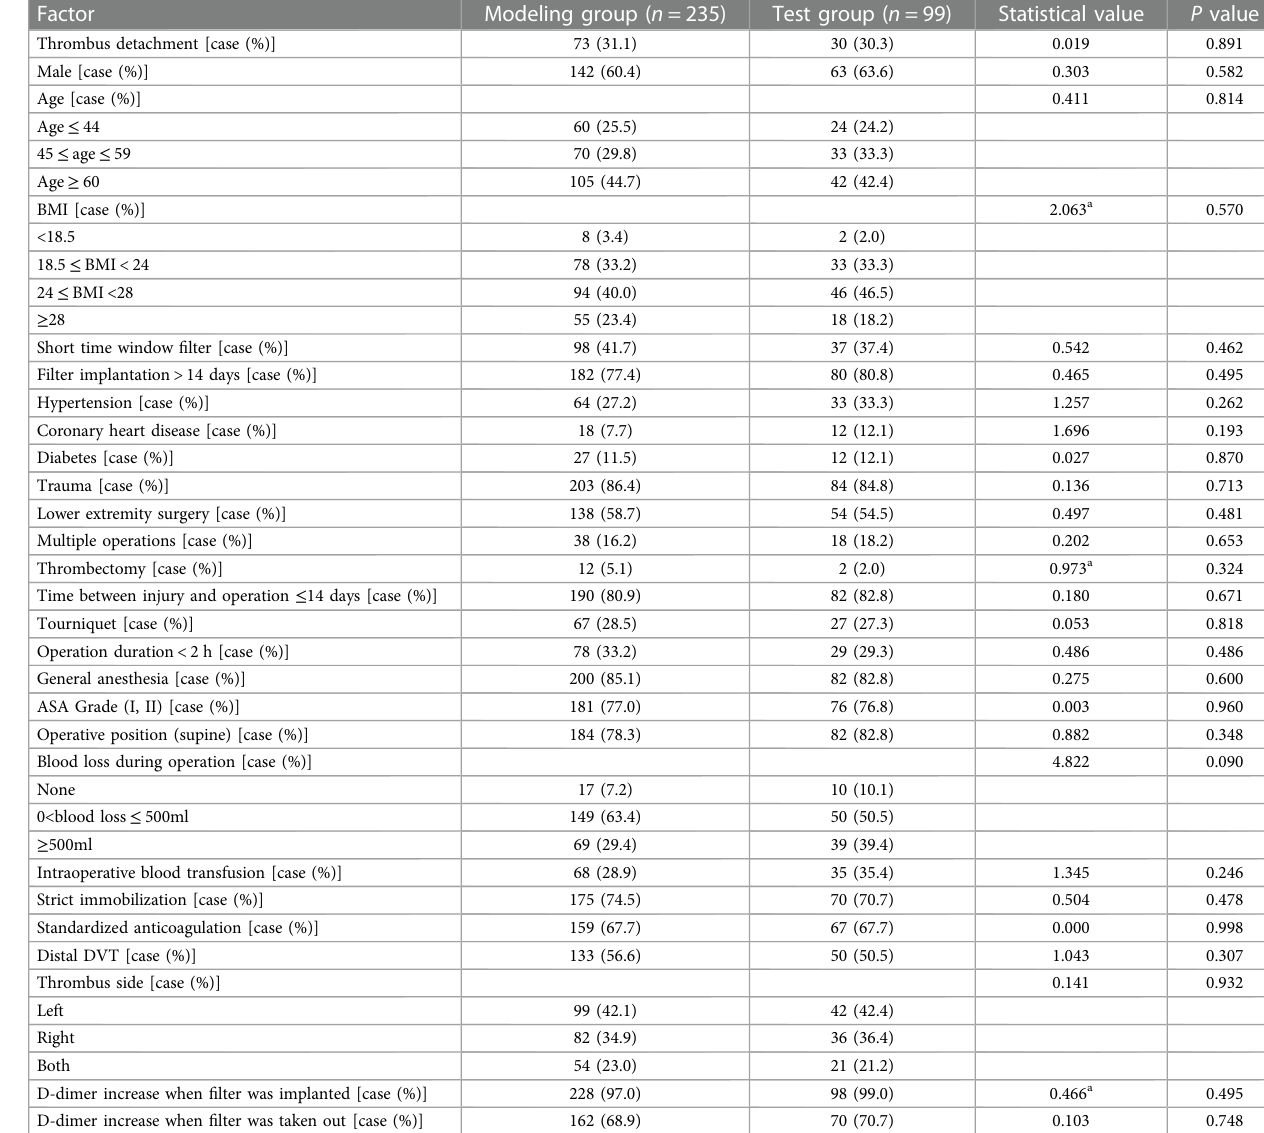
TABLE 1 Comparison of general data between training set and validation set.